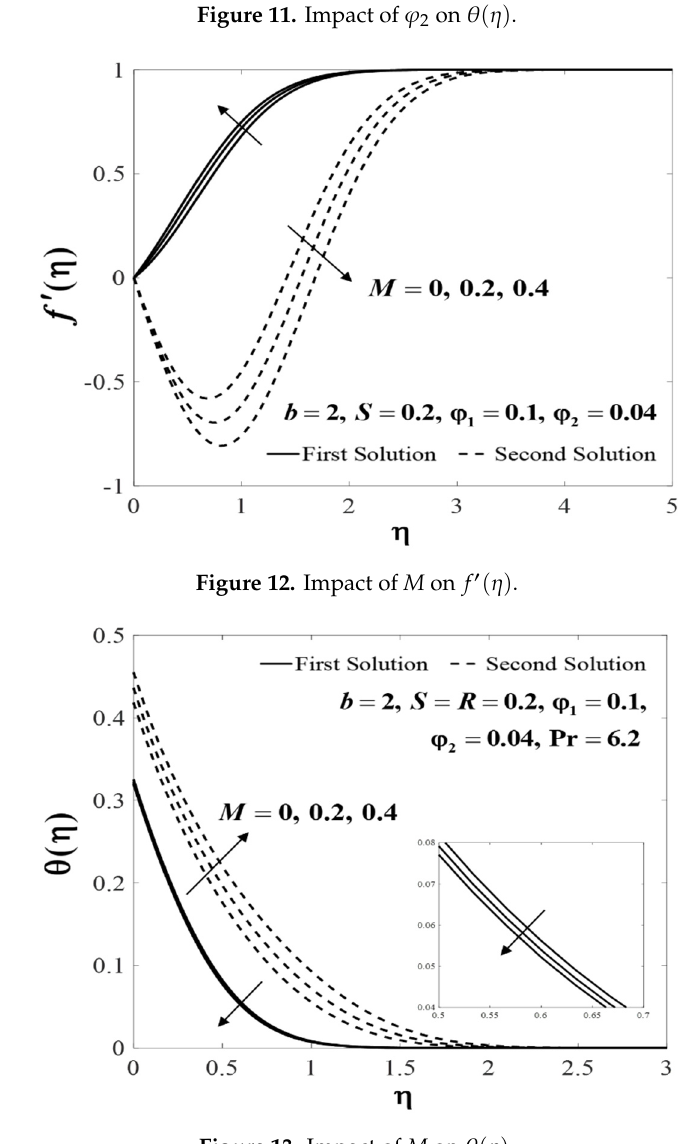
Figure 14. Impact of 𝑆 on 𝑓 ′ (𝜂) .